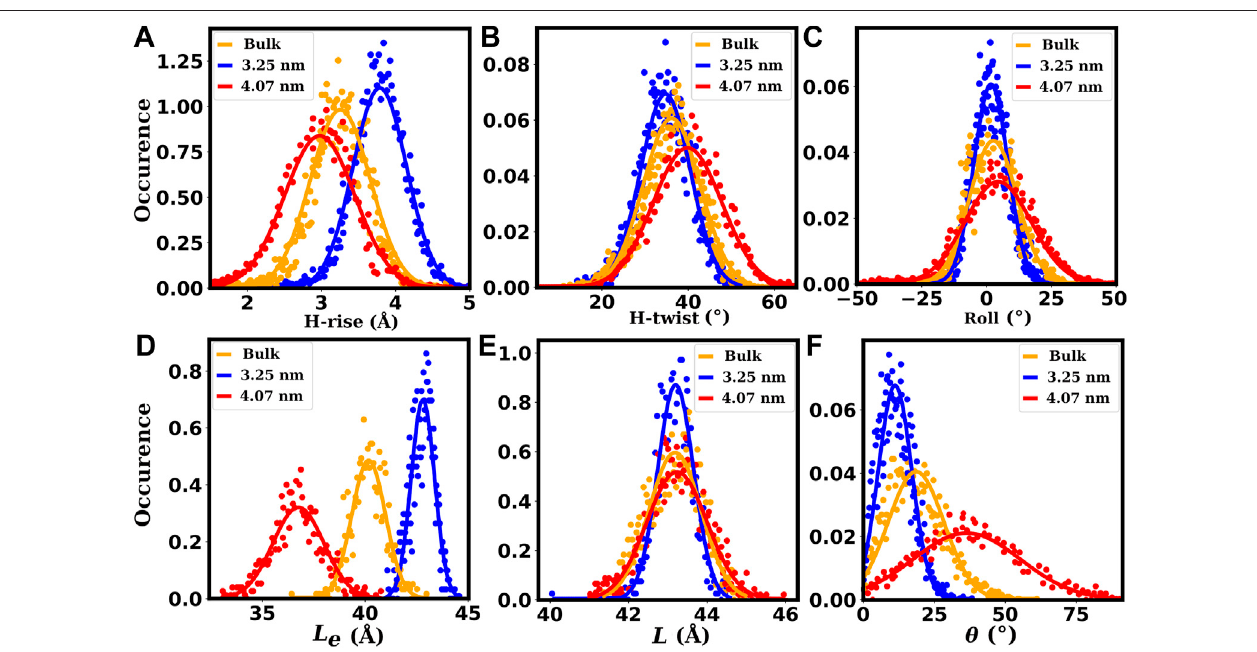
FIGURE 11 | Some of the helical (A – C) and structural (D – F) properties of the dsDNAs. The plots (A – C) show the distributions of helical rise (H-rise), helical twist (H-twist) and roll parameters, respectively. The plots (D – F) show the distributions of the end-to-end distance (L e ), contour length (L) and bending angle ( θ ), respectively. The red linescorrespondtochiralityindices(30,30)or4.07 nm diameterofSWCNT,representingdsDNAs con fi ned insidewider SWCNTs.Theblue lines correspond to chirality indices (24,24) or 3.25 nm diameter of SWCNT, representing dsDNAs con fi ned inside moderately wide SWCNTs. The orange lines correspond to bulk dsDNA without con fi nement.